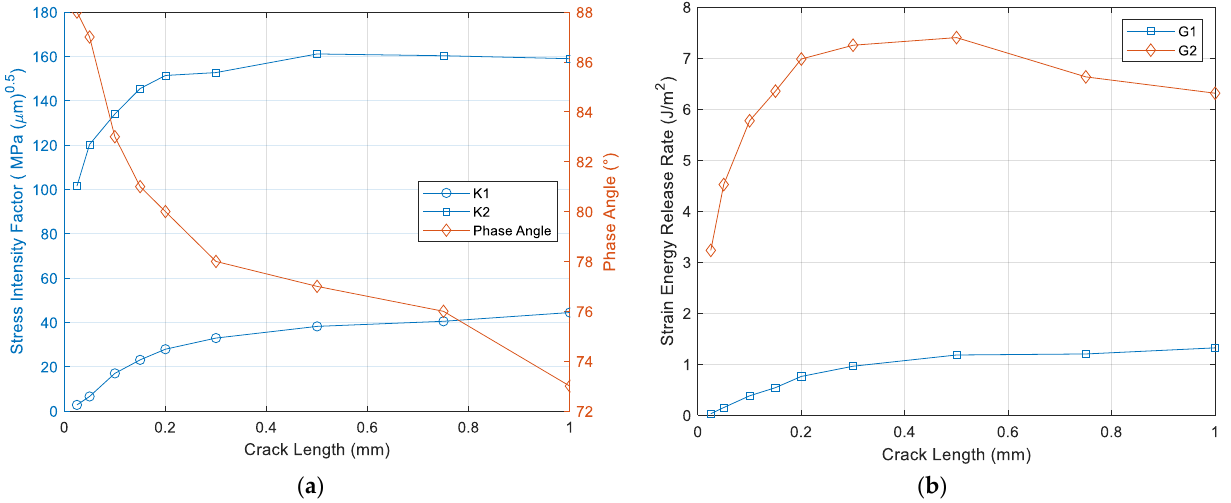
Figure 7. ( a ) Stress intensity factor, phase angle as function of crack length, and ( b ) strain energy release rate as function of crack length.